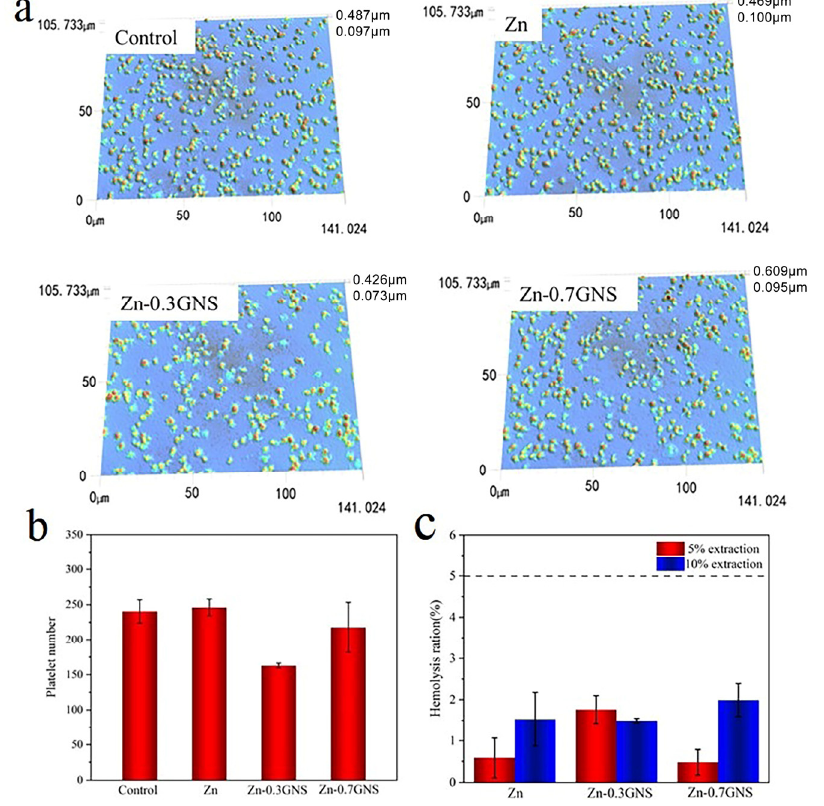
Figure 2. ( a ) 3D platelets adhesion morphology, ( b ) platelets adhesion number, and ( c ) hemolysis percentage of pure Zn and Zn-GNS composites.